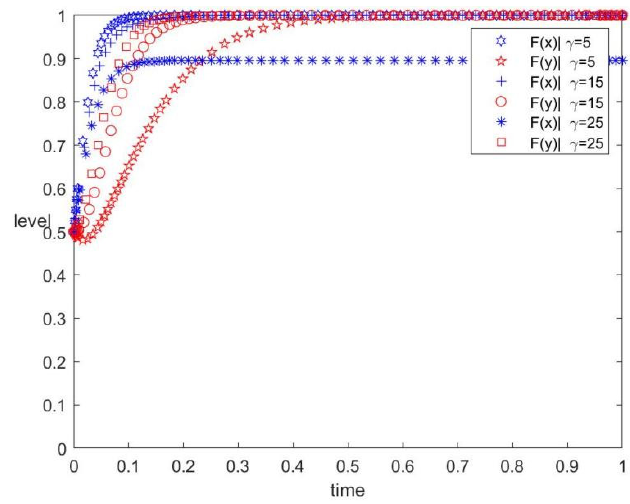
Figure 3. Evolution track under different subsidy intensities.